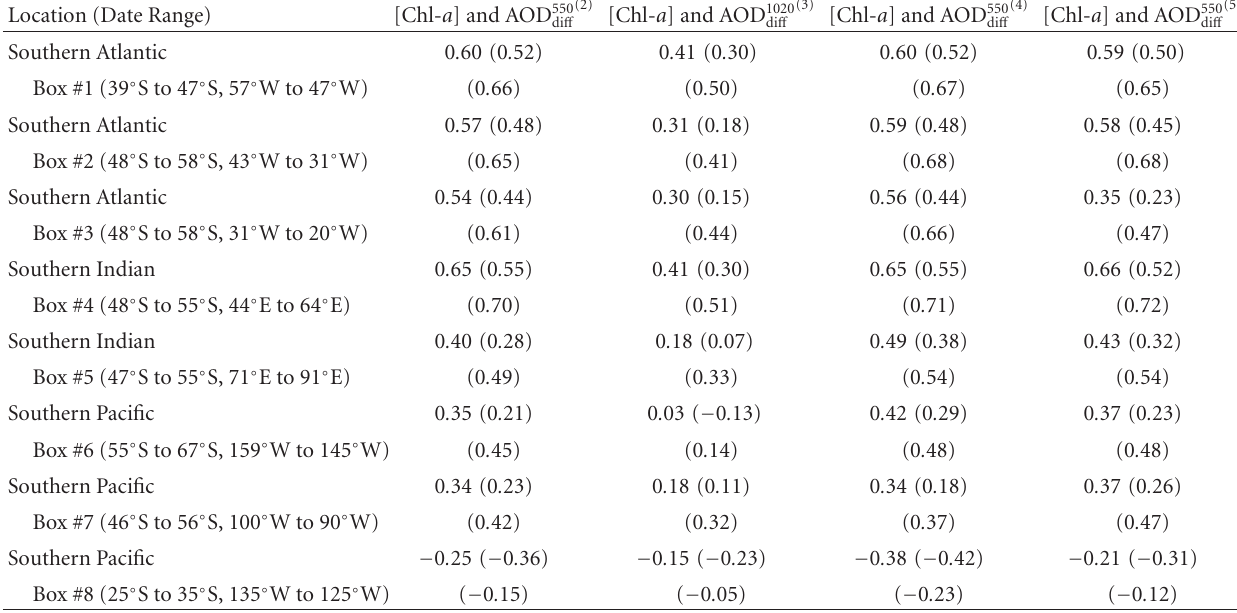
Table 4: Correlations of [Chl- a ] and AOD di ff for time series of Figure 5 (1)